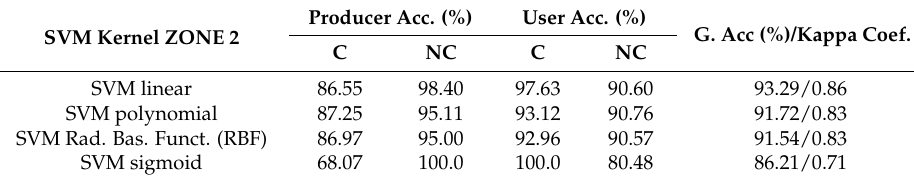
Table 9. DS2. Accuracy analysis of the SVM Fusion process.